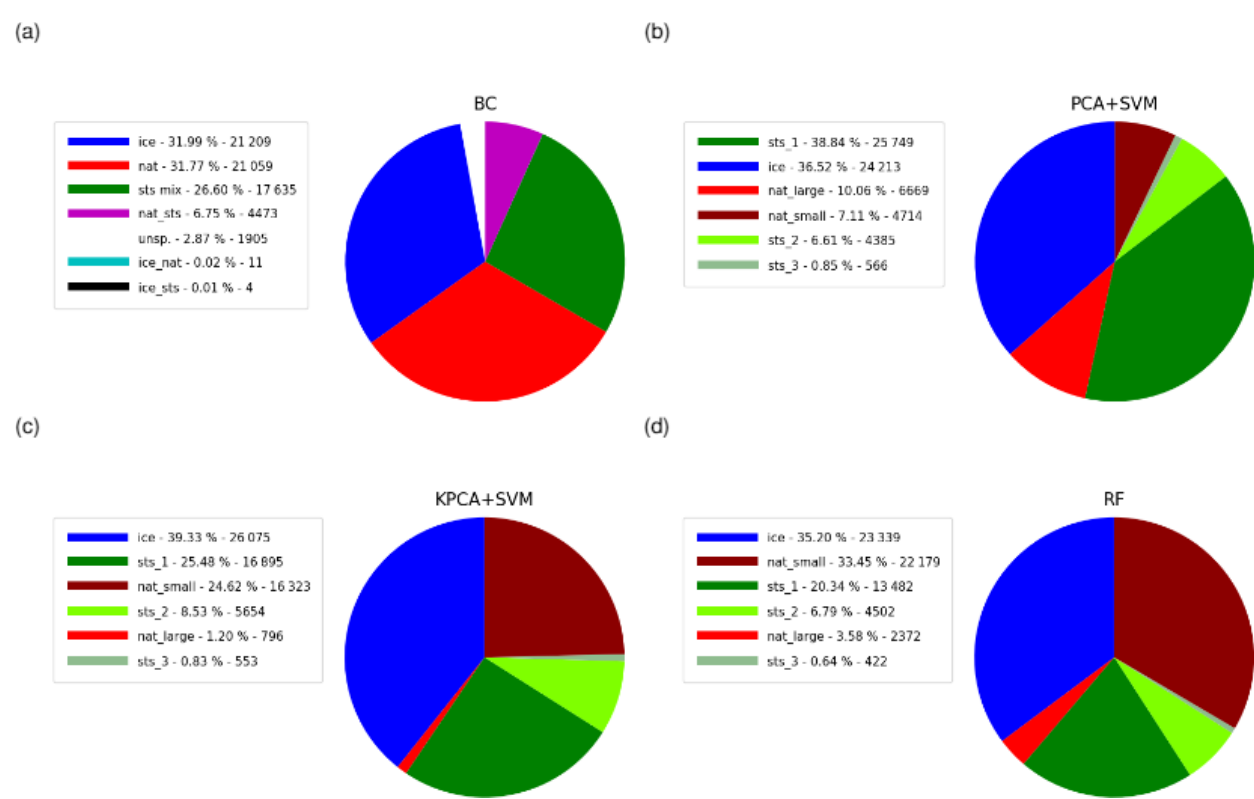
Figure 14. Partitioning of the PSC composition classes for the Southern Hemisphere winter (May to September 2009) derived by (a) the Bayesian classifier, (b) the PCA + SVM classifier, (c) the KPCA + SVM classifier, and (d) the RF classifier. Percentage values and number of events are reported in the